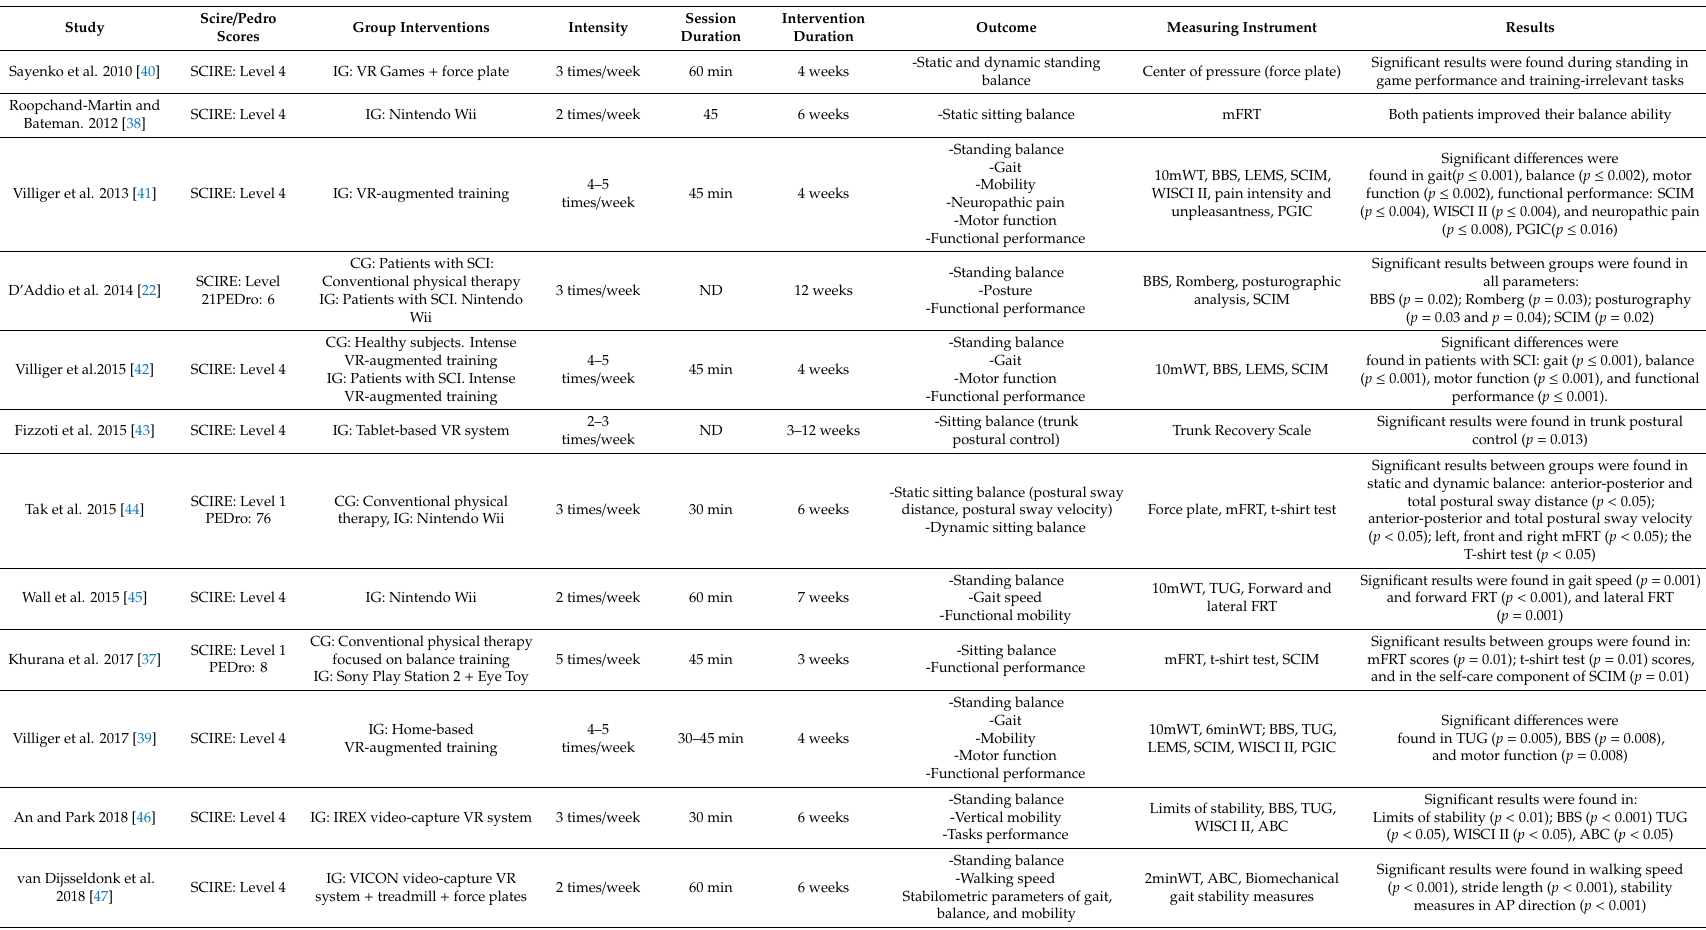
Table 2. Main characteristics of the studies included in the systematic